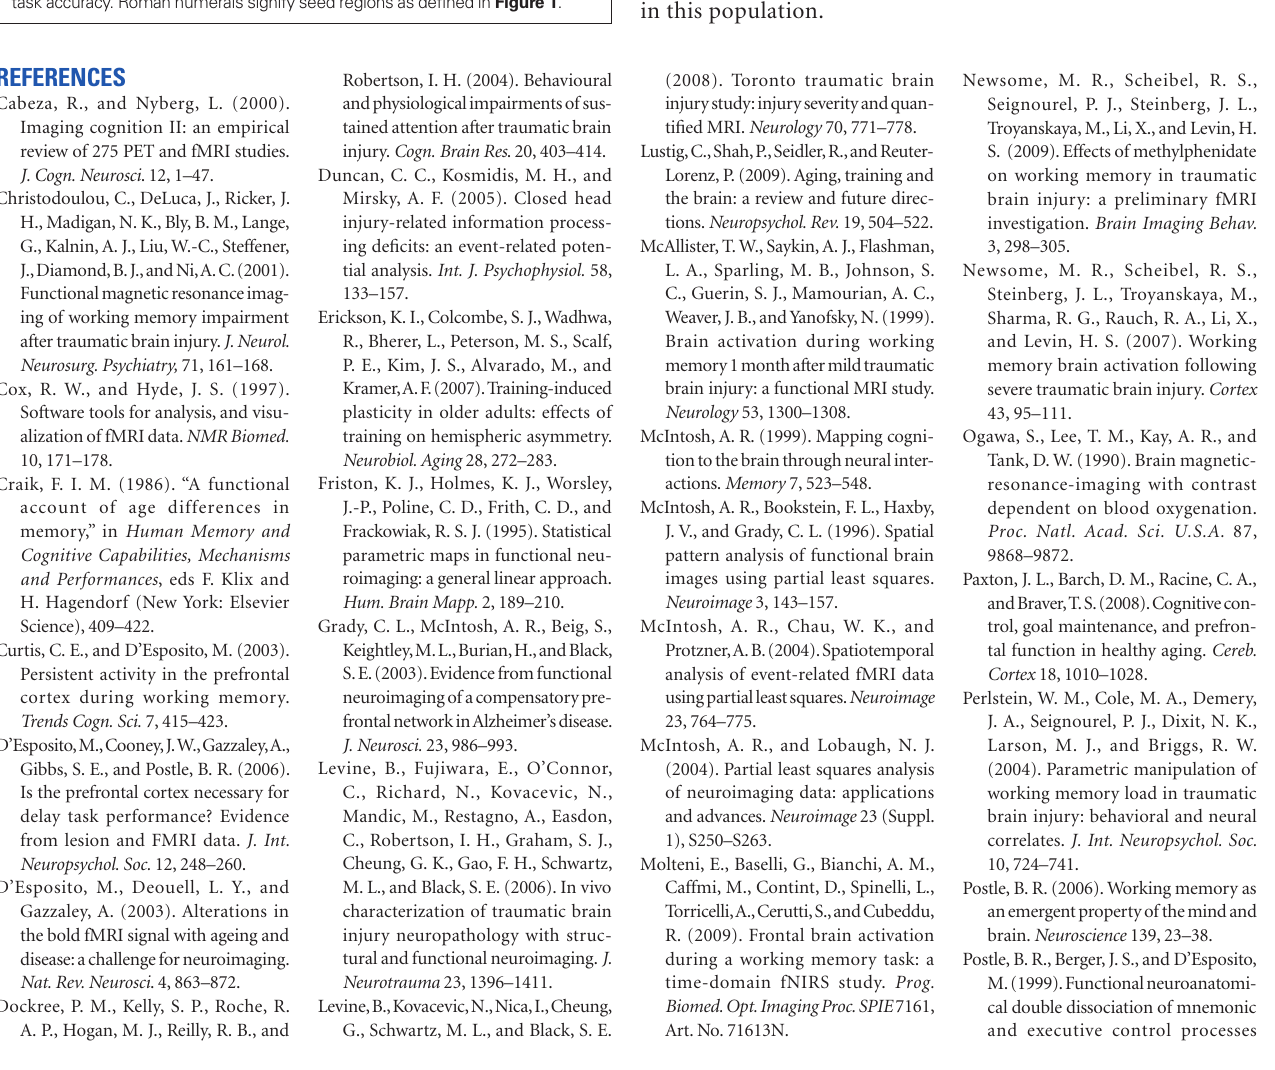
FIguRe 4 | Conceptual representation of combined behavioral and seed partial least squares analysis. Dashed lines connecting seed regions represent functional connectivity between these regions. Solid lines signify both functional connectivity and correlations between activity in the network and task accuracy. Roman numerals signify seed regions as defined in Figure 1